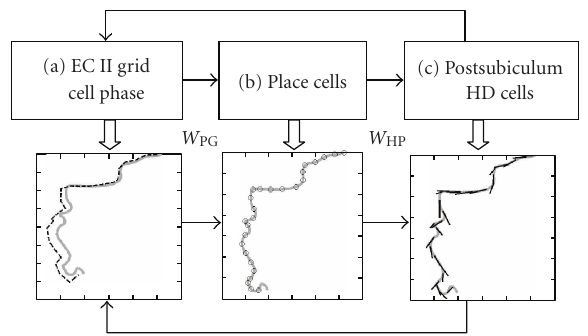
Figure 6: Model of episodic encoding and retrieval of trajectories. Top: Schematic representation of connectivity between grid cells, place cells, and head direction (HD) cells. Bottom: example of trajectory retrieval activity in each region. Trajectory experienced during encoding is shown in gray. (a) The location coded by the oscillation phase of entorhinal grid cell membrane potential is plotted as a dashed line that follows the actual trajectory in gray. Grid cell phase is put through the inverse head direction transformation to obtain coded location. Phase shifts are driven by retrieved head direction until next place cell is activated, then phase moves in new direction dependent on next active head direction cell. (b) Sequentially activated place cell representations are shown as open circles. (c) Each place cell activates a corresponding head direction representation, with direction shown as a short, straight, black line. This drives the next period of update of the grid cell